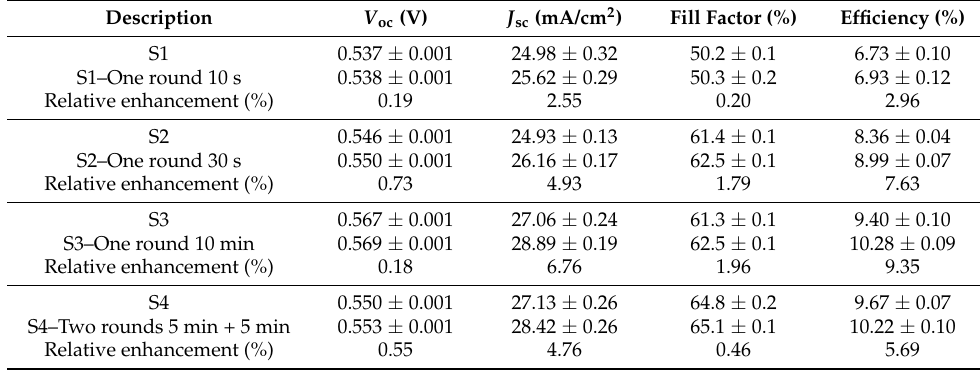
Table 1. RelativeenhancementofelectricalpropertiesofsamplesbeforeandafterSiO 2